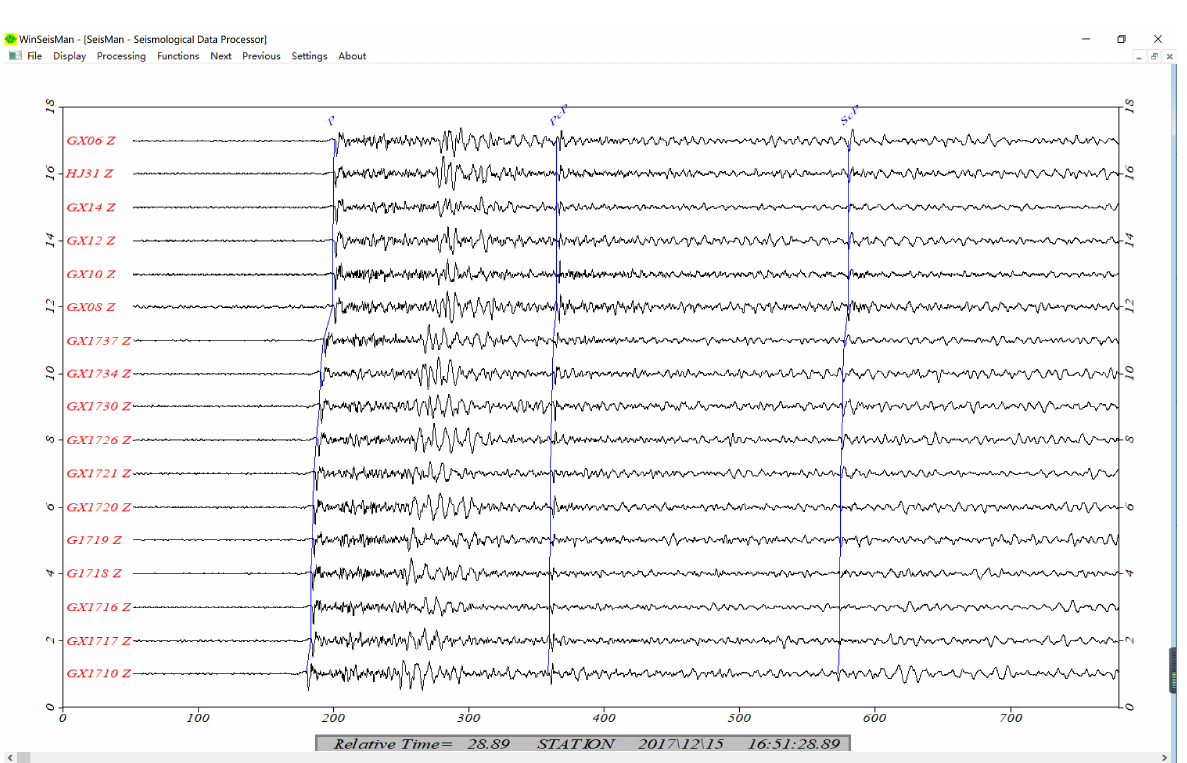
Figure 9. Multiple phases of this earthquake and their theoretical traveltimes (band-pass